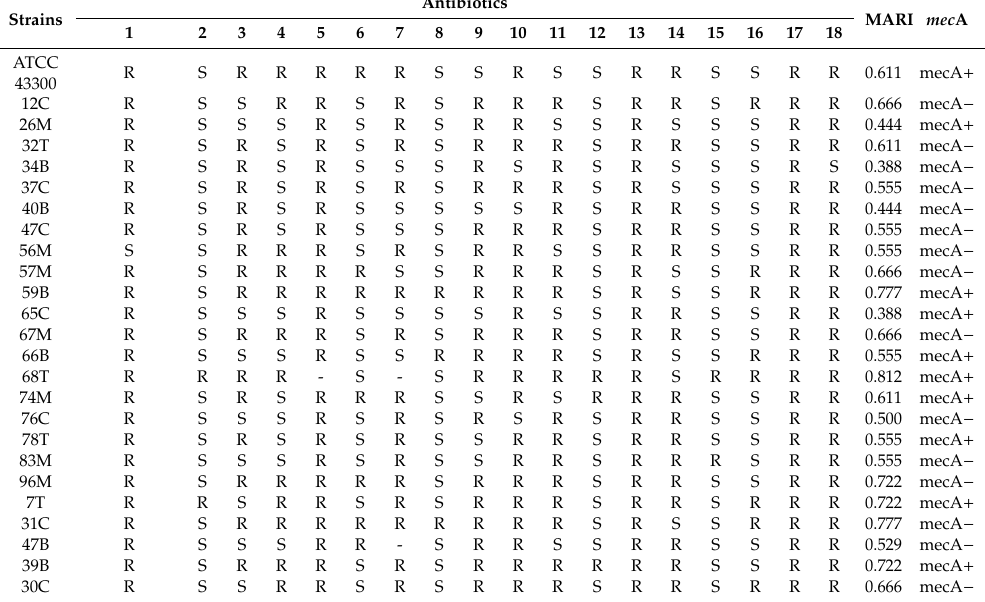
Table3. Susceptibilityprofilesof Staphylococcus spp. isolatedfromcellphonemobilesandPCR-detection of mec A